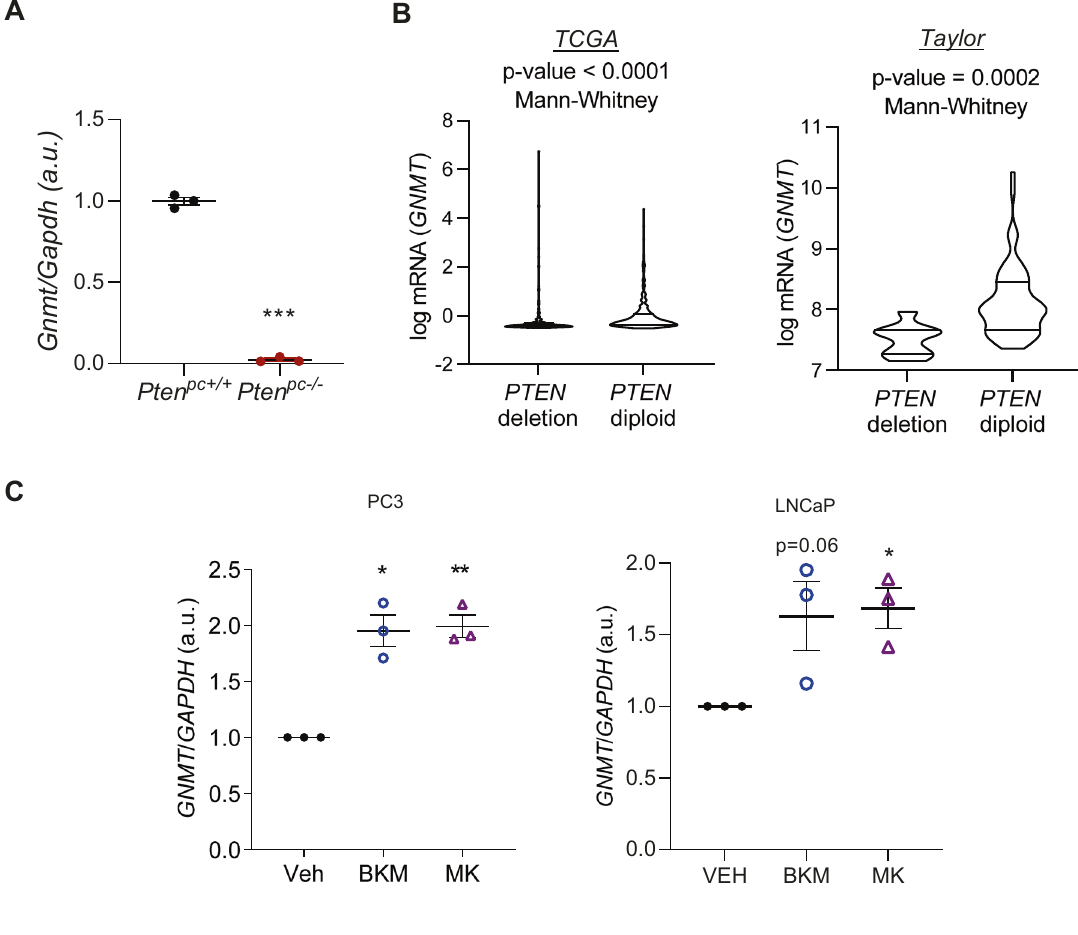
Fig. 1 PTEN regulates GNMT expression. A Gnmt mRNA expression in Pten pc − / − and Pten pc + / + prostate tissue from 6-month-old mice ( n = 3). B GNMT expression in PCa patient specimens with diploid or homozygous deletion of PTEN in two different datasets. Data was retrieved from www.cbioportal.org. C GNMT mRNA expression upon treatment (24 h) with Vehicle (Veh, DMSO), BKM120 (BKM, 5 µM) and MK2206 (MK, 500 nM) in PC3 and LnCaP cells ( n = 3). Data are represented as mean with SEM ( A , C ) and violin plot ( B ). Statistic test: Student T -test ( A ); Mann – Whitney U -test ( B ) and One sample T -test ( C ). p , p value; * p < 0.05; ** p < 0.01; *** p <